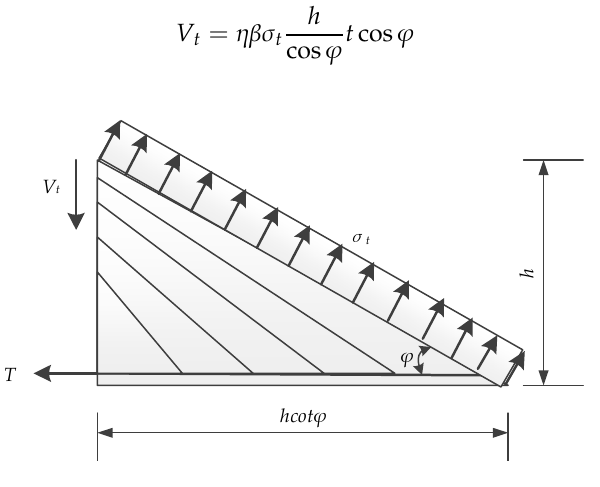
Figure 8. Left isolation body for Truss Model.